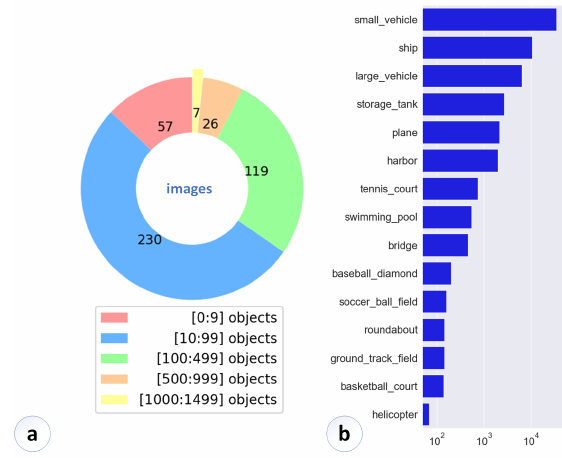
Figure 4. Density and class distribution of the evaluation dataset. From the iSaid validation dataset we select all images with less than 1500 objects for evaluation. (a) In this chart, we show the amount of images for the given object count